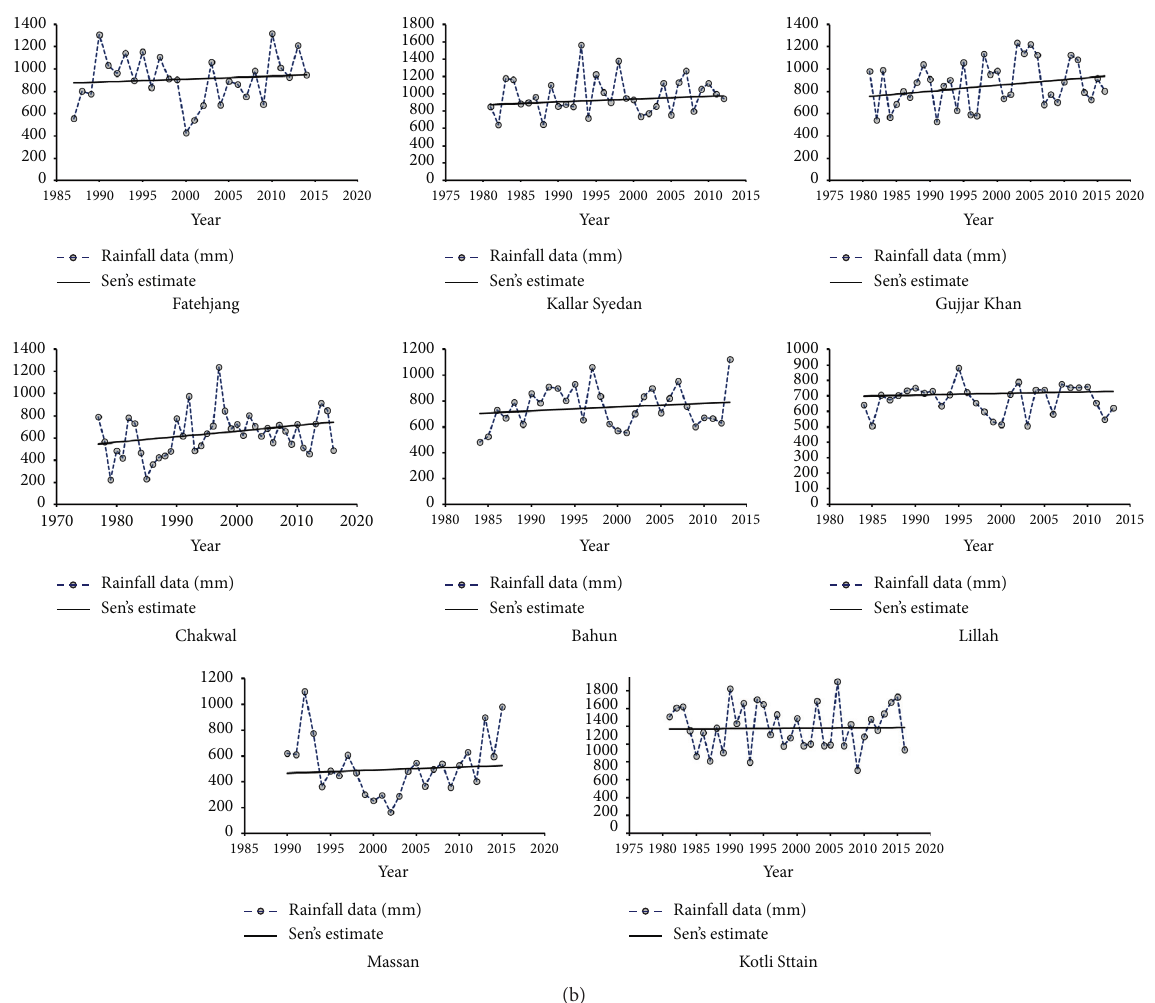
Figure 7: Temporal rainfall trend analysis of SRB rain gauge stations on an annual basis; (a) decreasing trend stations (Murree, Islamabad, NARC, and Rawalpindi stations belong to zone-1; Mangla and Jhelum belong to zone-2; Khewra and Talagang belong to zone-3); (b) increasing trend stations (Fatehjang, Kallar Syedan, and Gujjar Khan belong to zone-2; Chakwal, Bahun, Lillah, and Massan belong to zone- 3; Kotli Sattian belongs to zone-1). The scale of the figures is adjusted to the rainfall